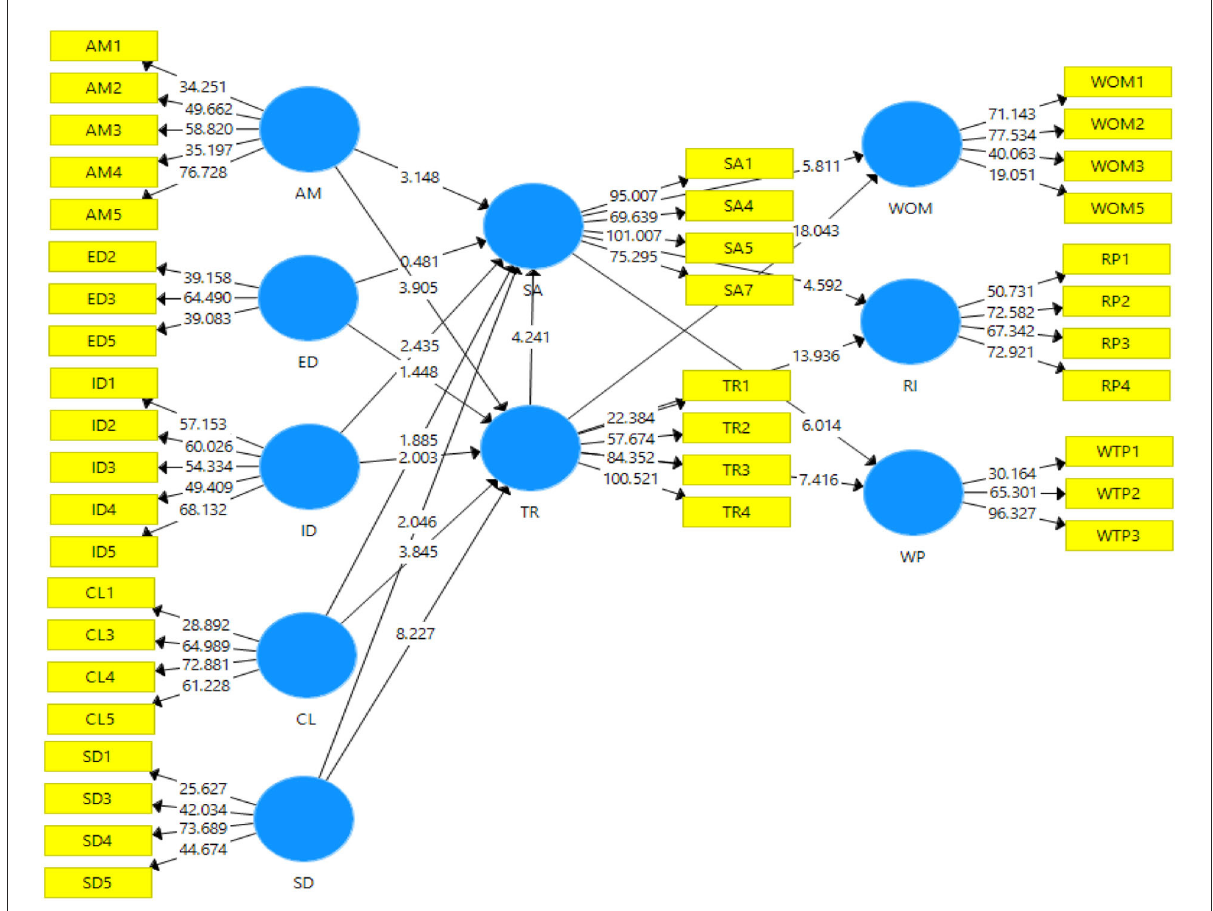
FIGURE3 Structural